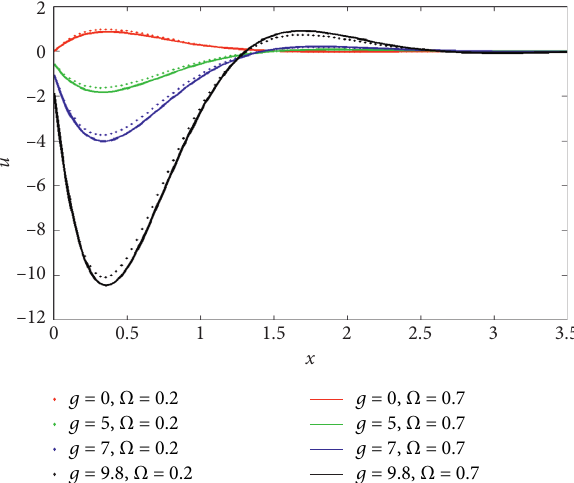
Figure 9: Temperature T concerning x under four thermoelastic theories.